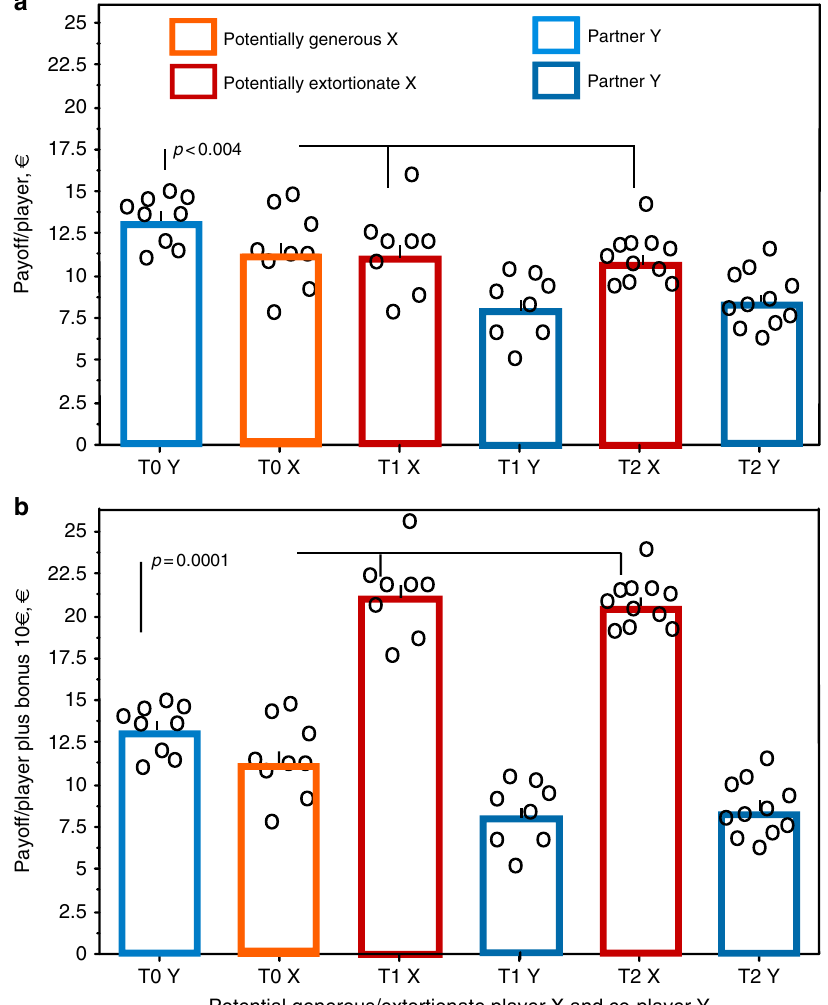
Fig. 4 Payoff per player without and with bonus. Payoff ( € ) per player over 49 rounds in the treatment without incentive (T0), with asymmetric incentive (T1) and with symmetric incentive (T2). Players have been selected as in Fig. 2. Panel a shows payoffs without the additional bonus of 10 € added; p after two-tailed Mann – Whitney U test comparing the payoff of the partners of the potential generous ZD players in T0 with the payoff of the potential extortionate ZD players, pooled from the two treatments with incentive to earn the additional bonus T1 and T2; N 1 = 9 (T0), N 2 = 19 (T1, T2), Z = − 2.902, p = 0.0037). Panel b shows payoffs with the additional bonus of 10 € added; Z = − 4.208, p =